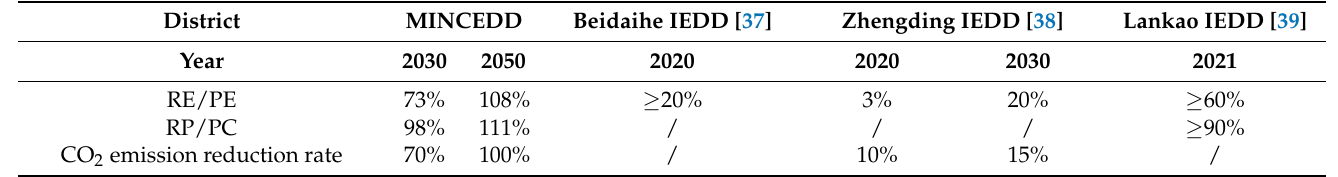
Table 20. The comparison of the MINCEDD indexes and those of other districts outside of Zhejiang. District MINCEDD Beidaihe IEDD [37] Zhengding IEDD [38] Lankao IEDD [39] Year 2030